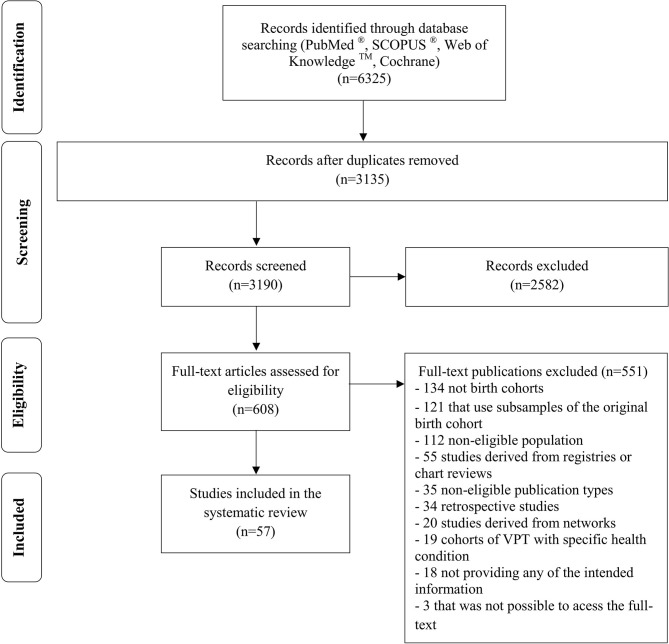
PRISMA systematic review flowchart. Search Expression—PubMed®: (participation OR “response rate” OR “response proportion” OR “follow-up rate” OR “follow-up proportion” OR “follow-up participation” OR “follow-up strategy” OR lost to follow-tip” OR “loss to follow-up” OR “retention rate” OR “retention proportion” OR “non-compliance” OR “non-response” OR “refusal” OR “attrition” OR “dropping out” OR “dropout” OR “drop-out” OR “reimbursement” OR “incentive” OR “motivation”) AND (“cohort” OR “prospective” OR “retrospective” OR “longitudinal” OR observational OR “population-based”) AND (“preterm” OR “premature” OR “prematurity” OR “low birth weight” OR “low birthweight”).